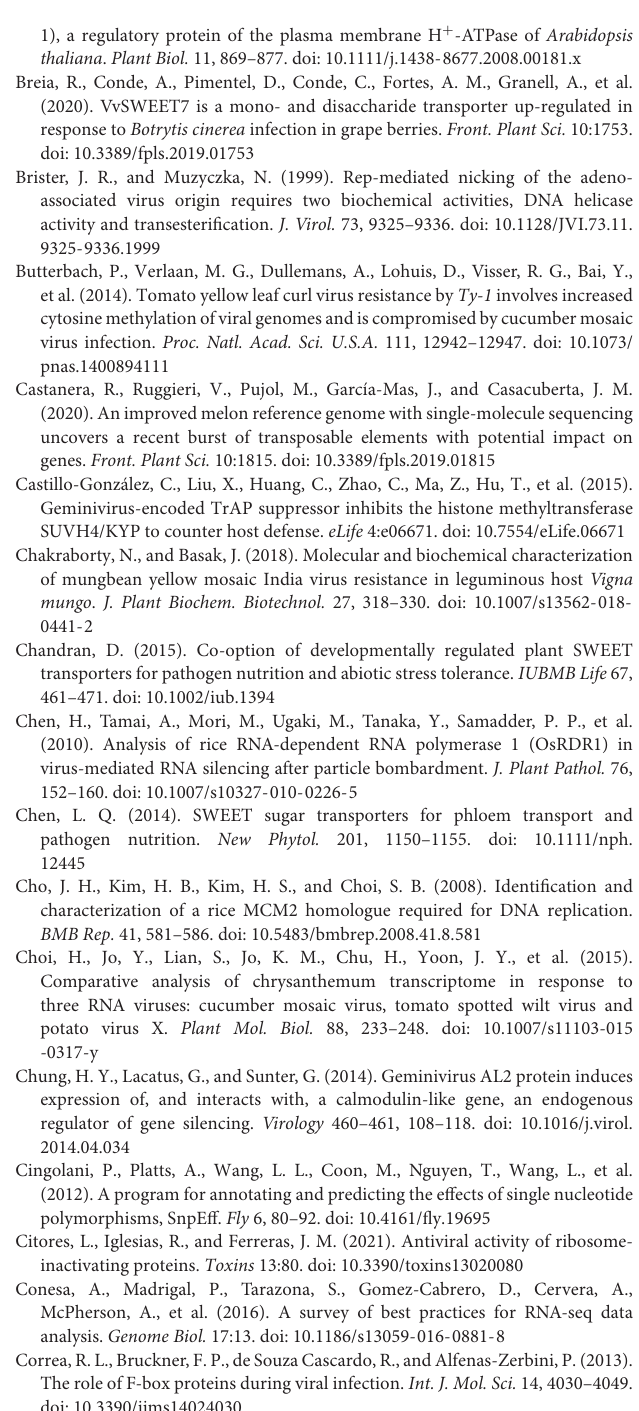
Supplementary Table 8 | Common DEGs at different stages (3, 6, and 12 dpi) after ToLCNDV inoculation in WM-7 genotype. Supplementary Table 9 | Common DEGs at different stages (3, 6, and 12 dpi) after ToLCNDV inoculation in PS genotype. Supplementary Table 10 | DEGs at 3, 6, and 12 dpi in the candidate regions of chromosomes 2 and 12 of PS and WM-7, conferring resistance to ToLCNDV.